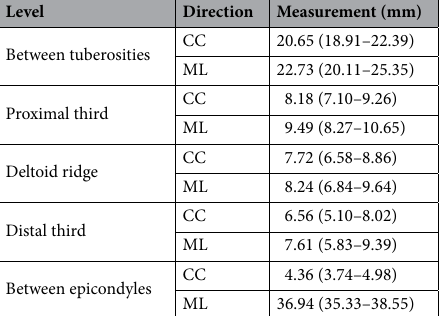
Table 2. Micro-CT measurements of internal diameter in both the craniocaudal (CC) and mediolateral (ML) planes of the koala humerus at each of the five measurement levels represented as mean with 95% confidence